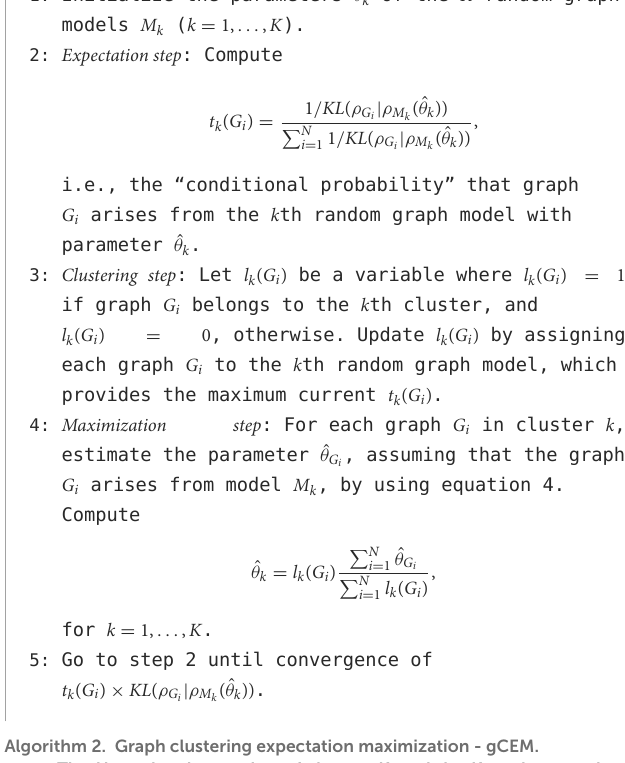
Algorithm 2. Graph clustering expectation maximization - gCEM. Input : The N graphs, the number of clusters K , and the K random graph models M 1 , M 2 , ... , M K . Output :The K clustersandthesetofestimatedparametersforeachcluster (random graph